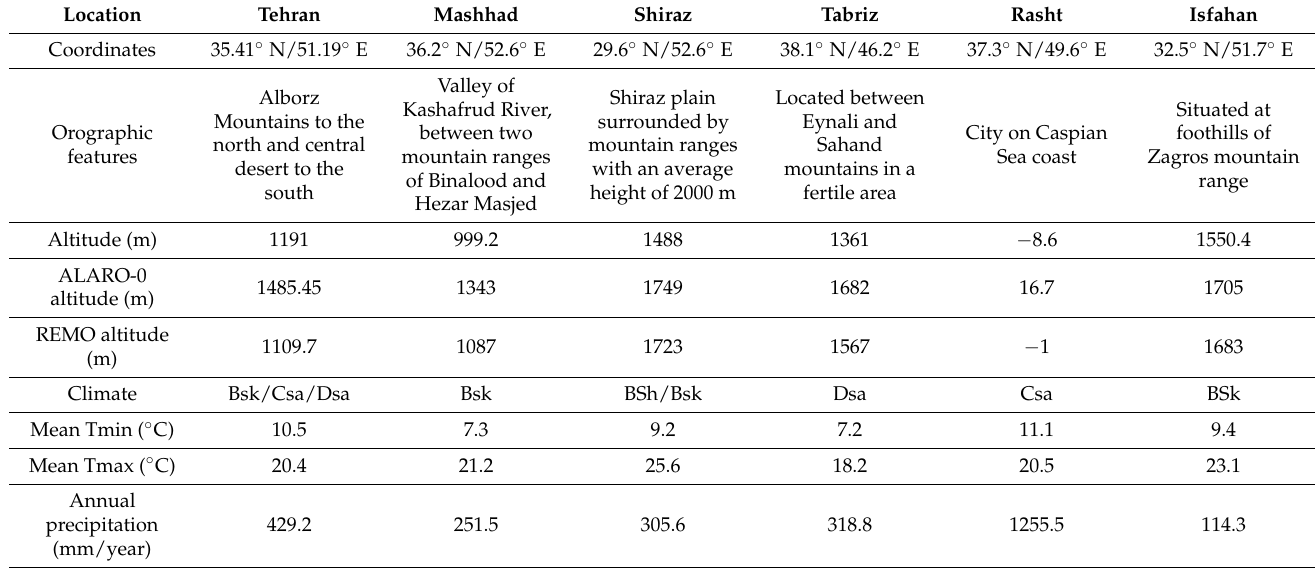
Table 1. Overview of 6 point locations and their climate